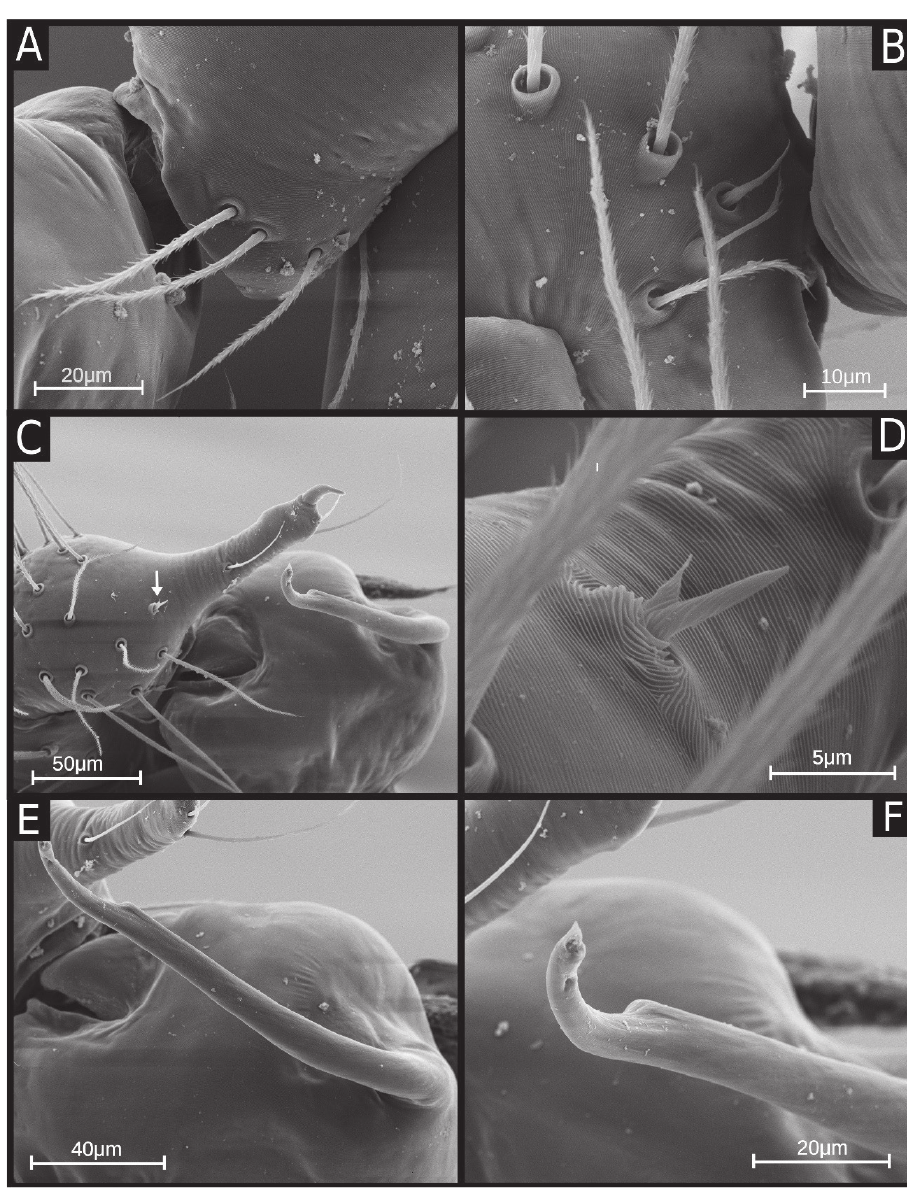
Figure 3. SEM images of Ochyrocera dorinha sp. nov., male palp (IBSP 189194) A cymbial extension, prolateral view B same, prolateral view C cymbium and bulb, anterior view D cymbium, tarsal organ, detail E embolus, ventral view F embolus, distal area, detail, ventral